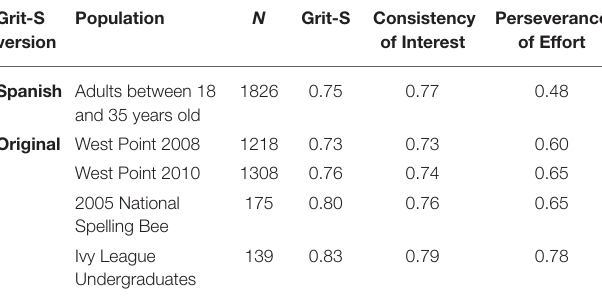
TABLE 3 | Internal Consistency of the Original English and Spanish Versions of the Grit-S